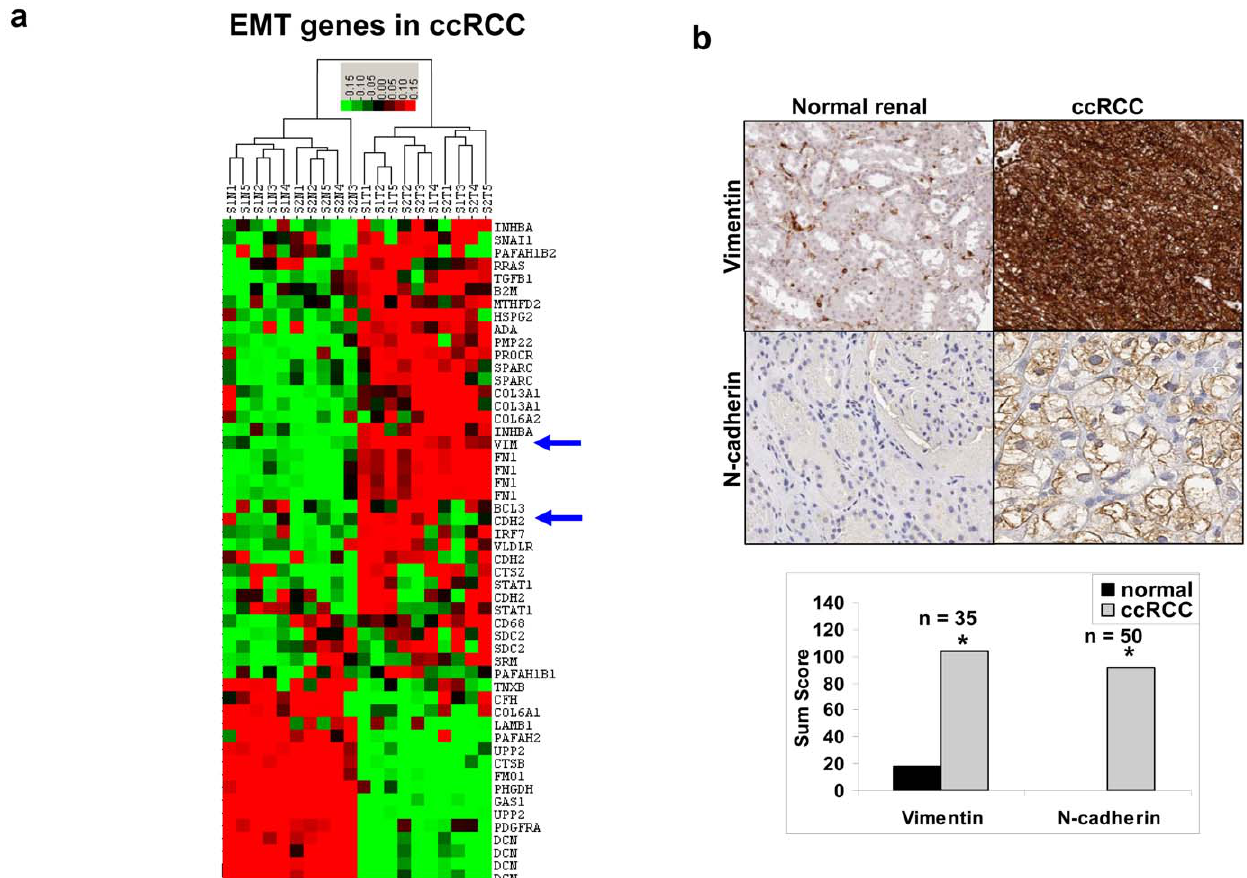
Figure 7. Epithelial mesenchymal transition in ccRCC. a. A heatmap showing the increased expression of some markers associated with EMT. Upregulation of genes is indicated in red, downregulation is indicated in green, and similar expression is indicated in black. b. IHC validation of two known markers of EMT: vimentin and N-cadherin. Sum scores are shown with n , as indicated. *p , 0.01 when comparing ccRCC to normal match.